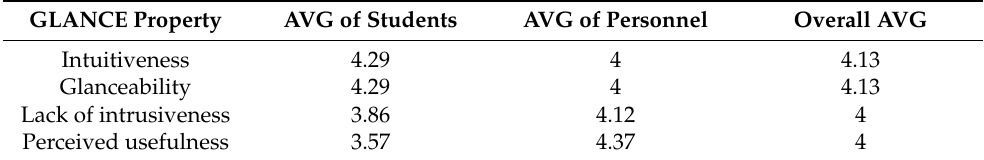
Table 9. Subjective GLANCE